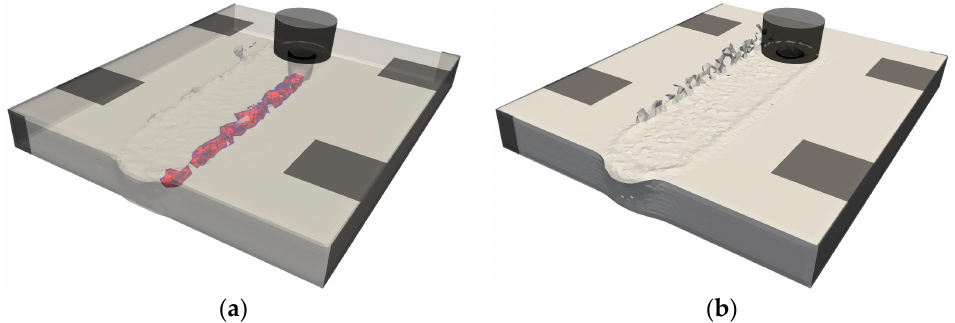
Table 4. Process parameter sets for